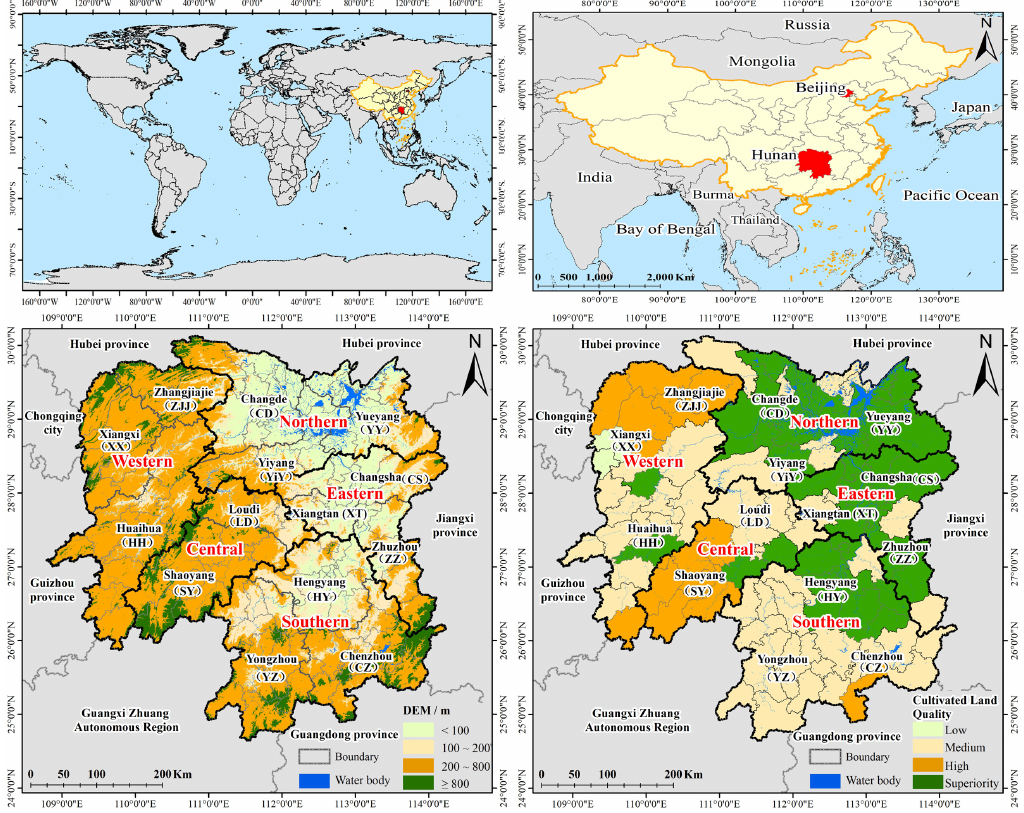
Figure 1. Sketch of the study area.